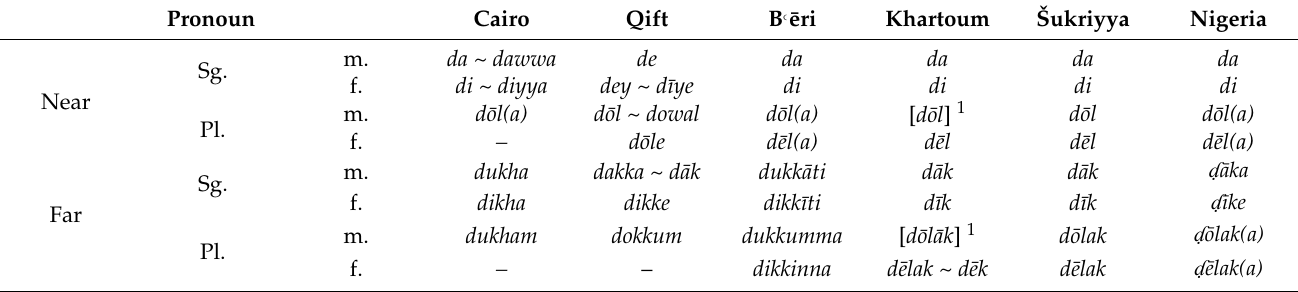
Table 4. Demonstrative Pronouns.